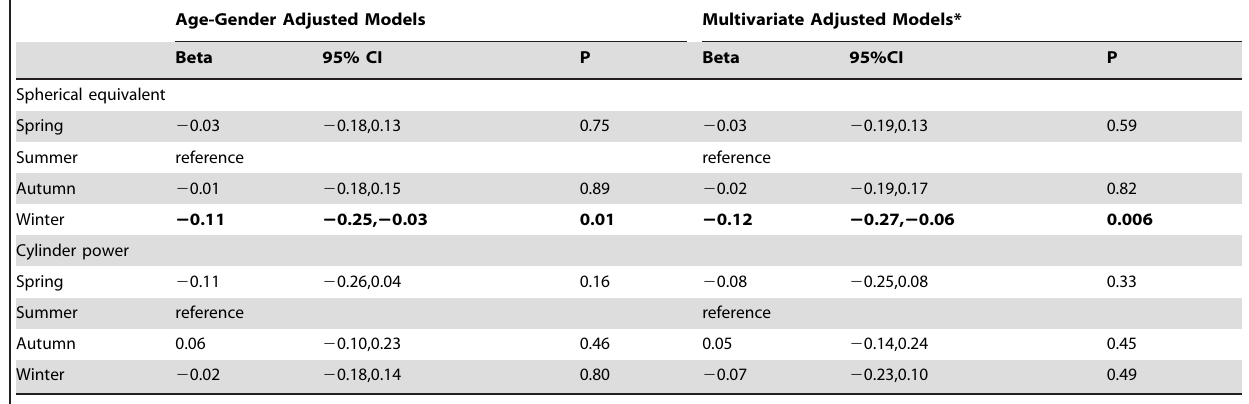
Table 2. Association of season of birth and refractive